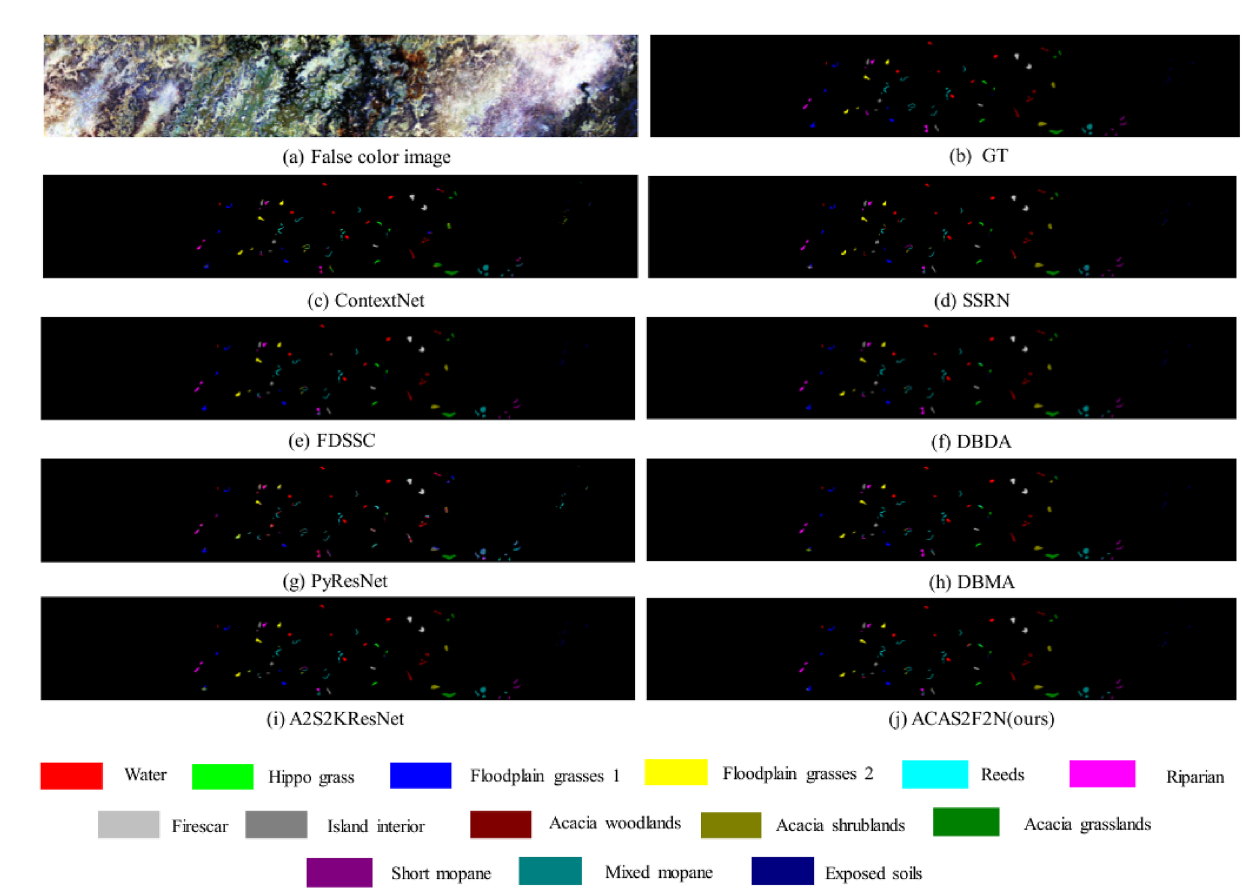
Figure 7. Hyperspectral classification maps on Botswana. ( a ) False color image. ( b ) Ground truth. ( c – i ) Performance of all baselines. ( j ) Performance of the proposed ACAS2F2N. The other content is color and label